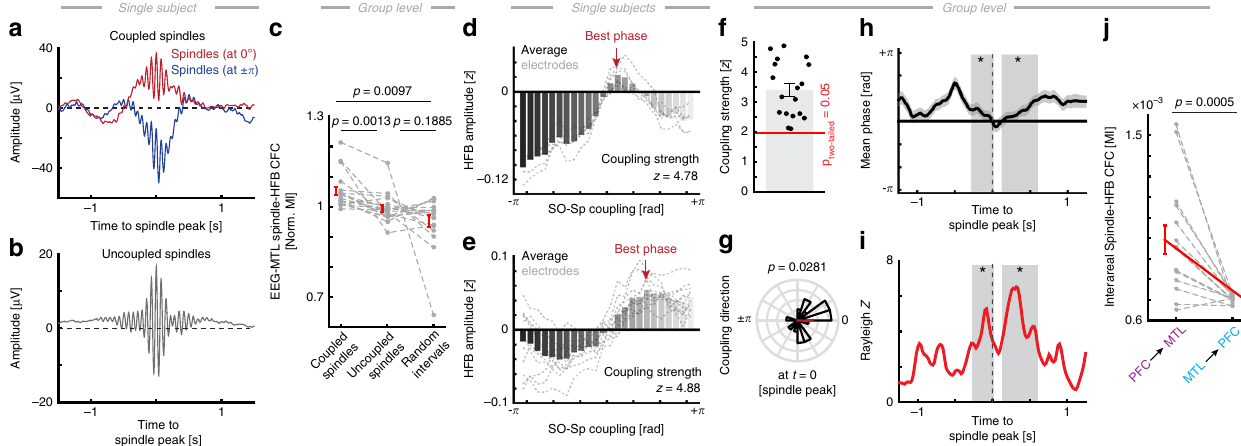
Fig. 3 Precise cortical SO-spindle coupling phase predicts MTL HFB activity. a Single subject average of all coupled spindles that were nested in the SO peak (in red) and trough (in blue). b All uncoupled spindles, i.e. that did not coincide with a separate SO detection. c Cortical spindle to MTL HFB phase amplitude coupling for coupled and uncoupled spindles as well as event-free random NREM intervals (normalized by the individual mean to reduce inter- subject variability). d Single subject HFB activity in the MTL as a function of the precise cortical SO-Spindle phase at the time of the spindle peak. Bars depict the average across electrodes; gray lines depict single electrodes. The red arrow indicates the SO-spindle coupling phase where the highest HFB amplitude was observed (~0°). e Different single subject example. Same conventions as in panel d . Note that HFB peaked after the SO peak (>0°). f Coupling strength: in every subject, we assessed the coupling strength by comparing the observed circular-linear correlation between SO-spindle coupling phase and HFB amplitude to a surrogate distribution. The correlation coef fi cient was then z -scored relative to a phase-shuf fl ed distribution of correlation coef fi cients and considered signi fi cant at z = 1.96 in individual subjects (corresponding to a two-tailed p < 0.05; red solid line). The gray bar depicts the mean across subjects; black dots depict individual subjects. We observed signi fi cant HFB modulations in 18/18 subjects (mean z = 3.40, p group = 0.0007). g Preferred coupling phase: circular histogram of the best phase (panels d and e ) where HFB peaked in individual subjects. At the group level, HFB amplitude was highest during the spindle when the spindle was nested in the SO peak (mvl = 0.44). h Preferred coupling phase across time (circular mean ± circular SEM). We repeated the analysis depicted in panel f for all time points (±1.25 s around the spindle peak). Shaded bars depict cluster-corrected signi fi cant Rayleigh tests (cluster p < 0.001) for circular non-uniformity (test for phase consistency at the group level), indicating that a preferred phase across subjects emerged around the spindle peak (cluster 1: − 0.3 to 0.04 s; cluster 2: 0.12 to 0.60 s); hence, the effect was transient and not